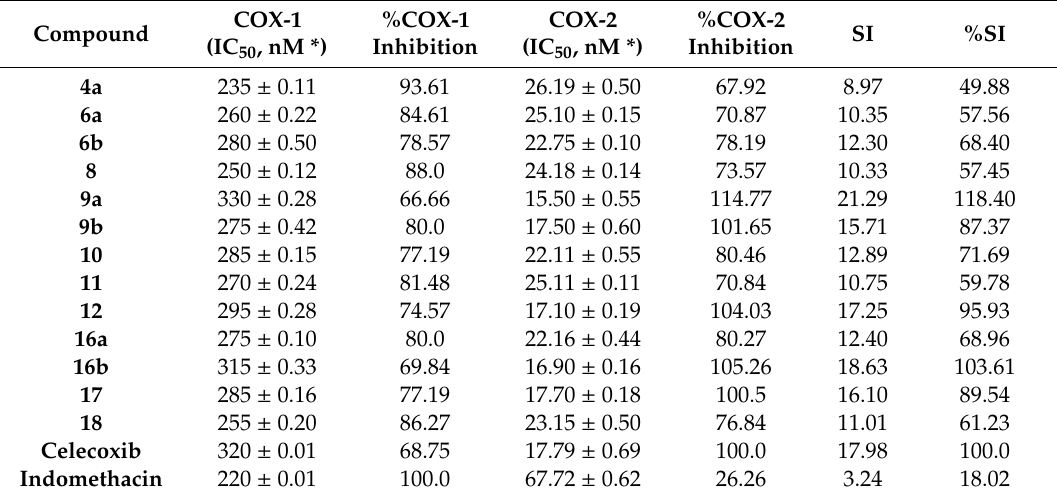
Table 1. In vitro cyclooxygenase inhibitory e ff ect (N = 3, Mean ± SD) of 4a , 6a , 6b , 8 , 9a , 9b , 10 , 11 , 12 , 16a , 16b , 17 , and 18 .